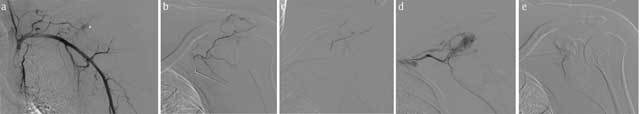
A 61-year-old man suffering from chronic osteoarthritis of the shoulder (so called “frozen shoulder”). (a) Arteriography of the left subclavian artery (LSA) showing the different collateral branches and a focal hypervascularization between the subacromial space and the humeral head (asterisk). Transarterial treatment by particle embolization: (b) selective catheterization of the thoraco-acromial artery and (c) control after superselective injection of 1.5 g of imipenem-cilastatin. Different articular branches (coracoid artery; anterior and posterior circumflex humeral; suprascapular) can be targeted to reduce te neo-angiogenesis related to the inflammation. In (d) and (e), embolization of the coracoid artery, respectively before and after the particle injection. Early results of this new therapeutic concept seem promising. Courtesy of Prof. M. Nakai and Prof. A. Ikoma from the Department of Radiology, Wakayama Medical University, Japan.